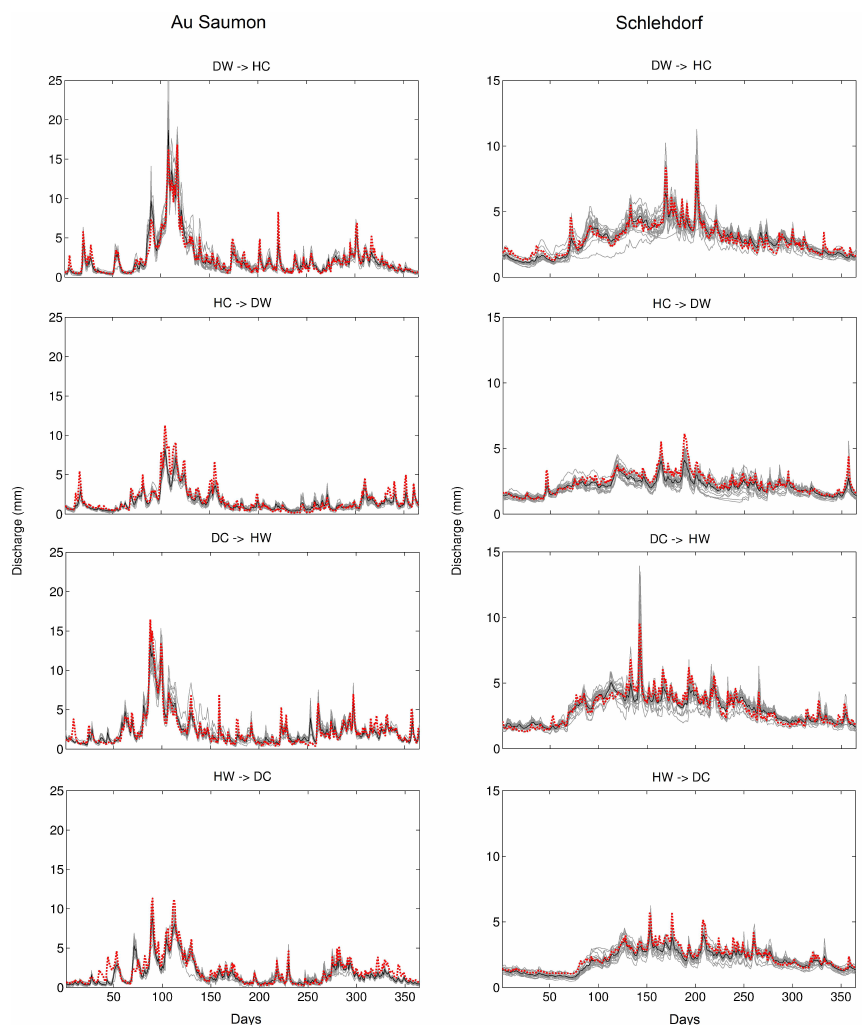
Fig. 5. Mean daily interannual discharges for all the DSS tests on validation periods, for the Au Saumon and Schlehdorf catchments. Grey lines are the twenty individual models, black line is the twenty-member ensemble and large red dotted line the observed